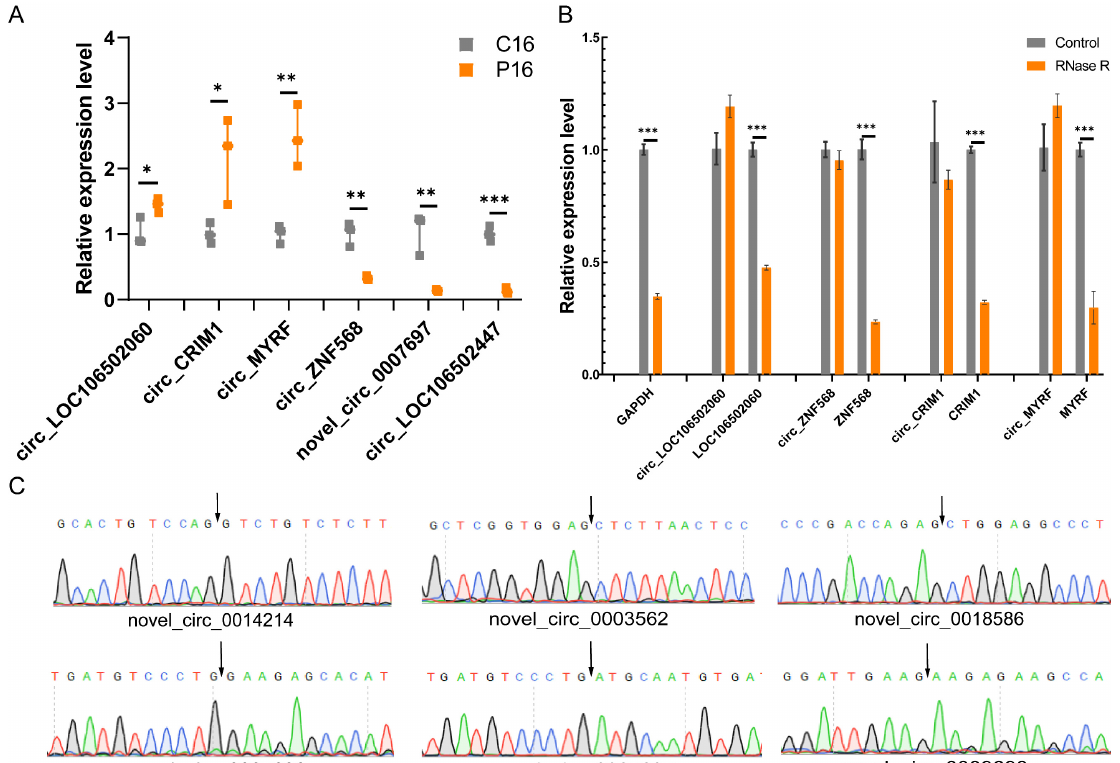
Figure 7. Validation of DE-circRNAs in the goat endometrium. ( A ) The relative expression level of DE-circRNAs were measured by qPCR in P16 and C16. ( B ) Validation of the resistance of DE-circRNAs and mRNAs to RNase R. There are three independent replicates per group, and the data are shown as the mean ± standard error of the mean (SEM) values. *, p < 0.05; **, p < 0.01; ***, p < 0.001. ( C ) The head-to-tail splice junctions for circRNAs were confirmed by Sanger sequencing. Black arrows represent the junction sites.